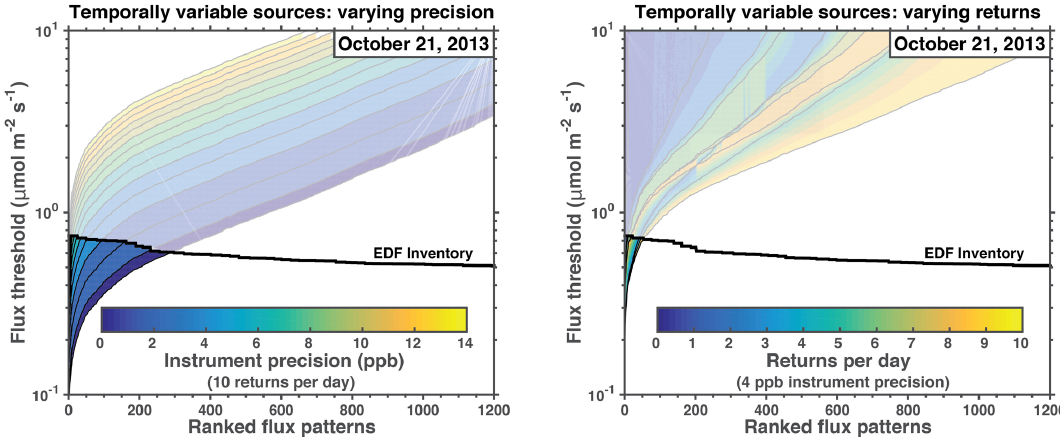
Figure 8. Same as Fig. 6 but for temporally variable sources on 21 October 2013.